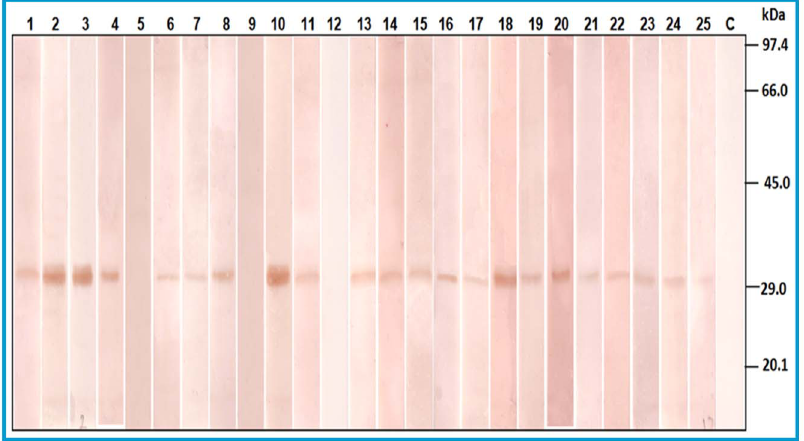
Figure 2. IgE binding of purified 31 kDa protein by immunoblotting. Lane 1 2 25: with individual patients’ sera and lane C: purified protein probed with normal human sera (control).